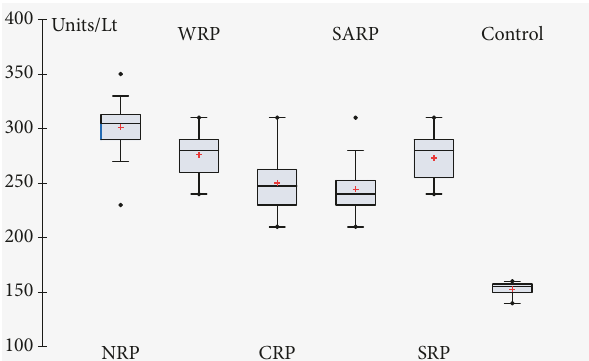
Figure 9: Serum Creatine Kinase (CK)